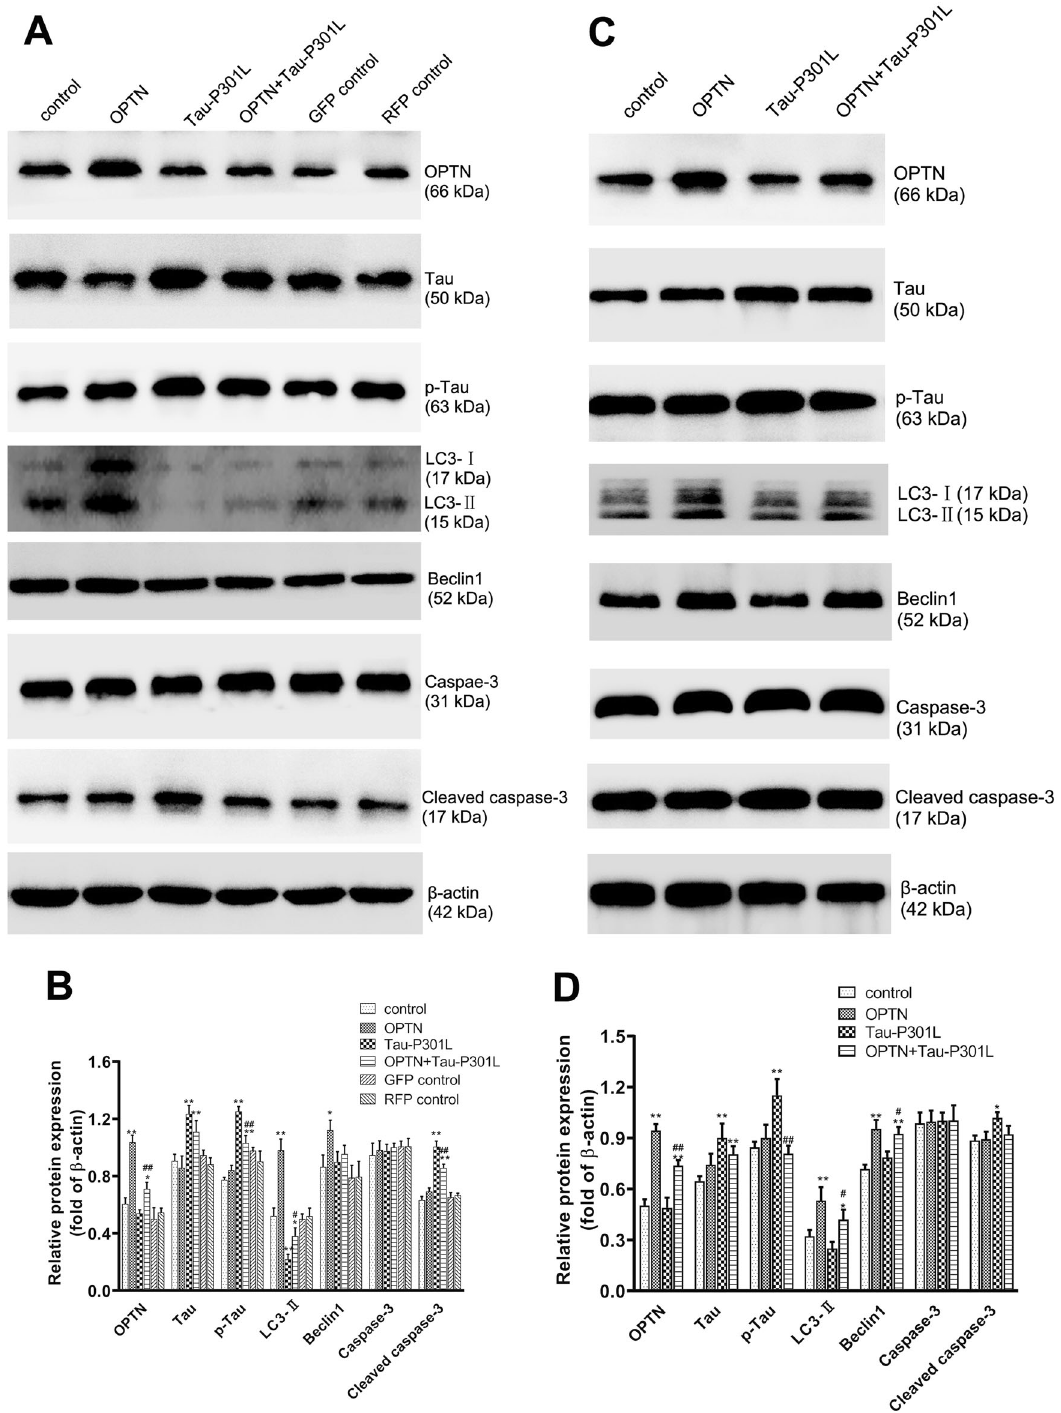
Fig. 6 OPTN regulates the levels of proteins associated to autophagy and apoptosis in cells or mice brain tissues infected AAV. A The related proteins were detected with western blotting in neuronal cell line HT22, and β -actin was used to show the similar amount of protein loaded in different lanes. C The related proteins were detected with western blotting in the brain tissues of mice, and β -actin was used as the reference protein. B , D Relative intensities of protein bands in A and C were determined using Quantity-One software and normalized to β -actin band intensity. Data in B and D are presented as mean ± SD (cell line: n = 6; mice: n = 10). * P < 0.05, ** P < 0.01 compared with control; # P < 0.05, ## P < 0.01 compared with TAU-P301L . GFP green fl uorescent protein, RFP red fl uorescent